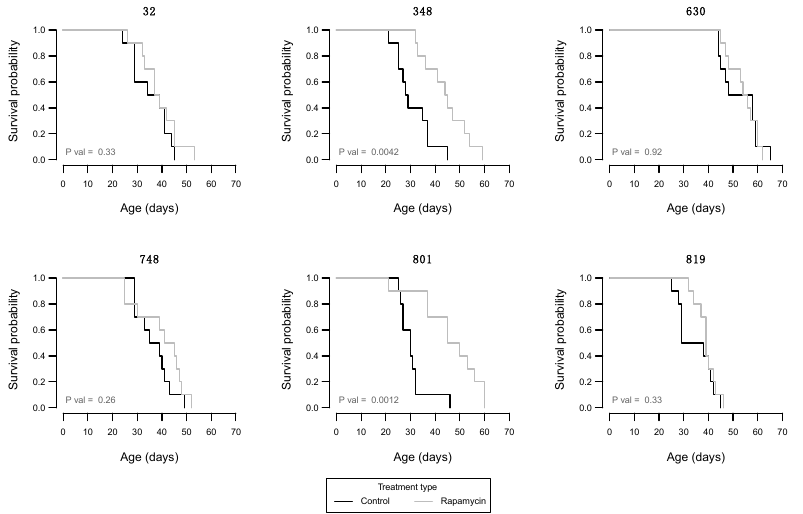
Figure 3. Kaplan–Meier plots of male D. melanogaster longevity within DGRP lines for flies exposed to the control treatment (black line) or the rapamycin treatment (grey line). p -values are from log-rank test.